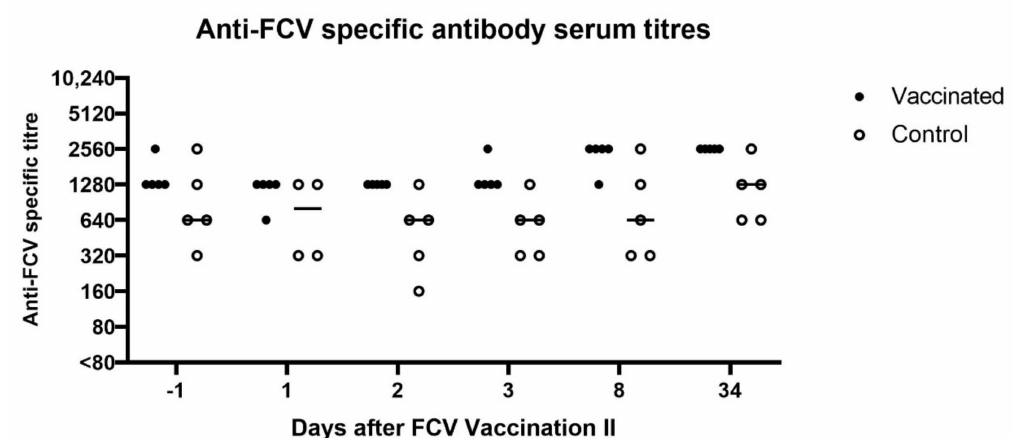
Figure 11. Dot plot of anti-FCV specific antibody serum titres measured by IFA before and after FCV Vaccination II in vaccinated and control cats, respectively. Antibody titres reflect the reciprocal of the last serum dilution showing positive fluorescence in the IFA. Each dot represents the titre of a cat of the vaccine or control group, respectively. At day 1, no IFA titre could be measured in the cat JJI4 of the control group due to not enough sample material. The horizontal bar represents the median. Day 34 correspond to day − 1 of FCV Challenge